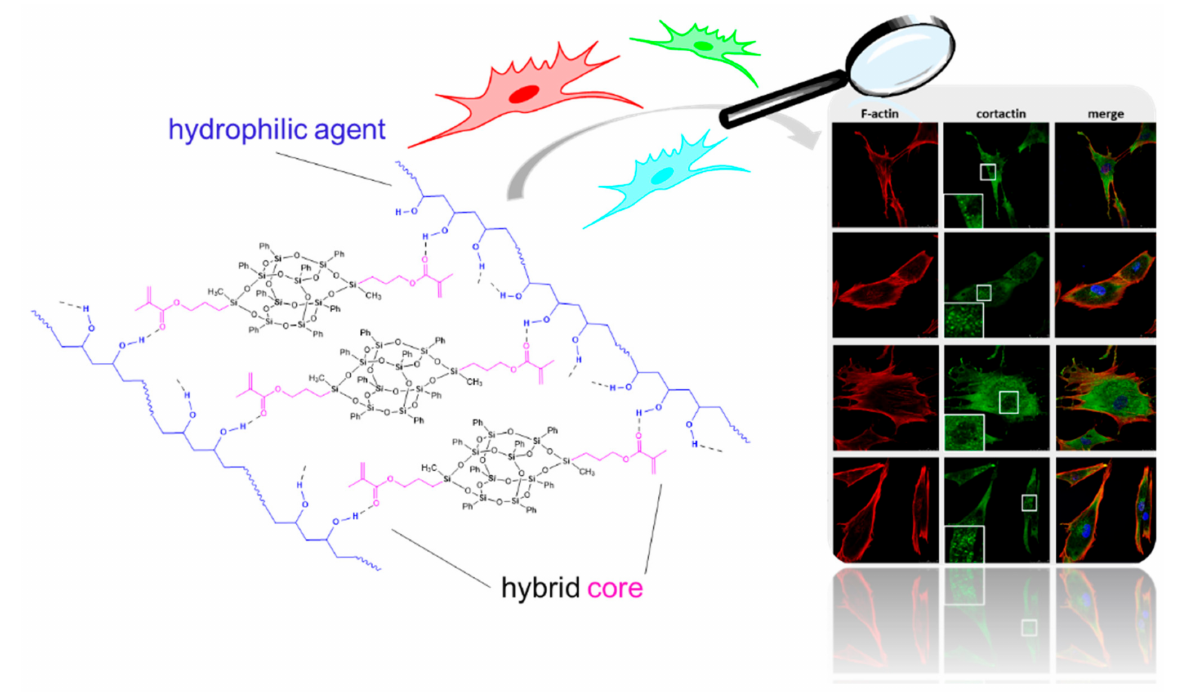
Figure 6. The idea of the hybrid biocomposite based on double-decker silsesquioxanes functionalized by methacrylate derivative and polyvinyl alcohol supports the fibroblast